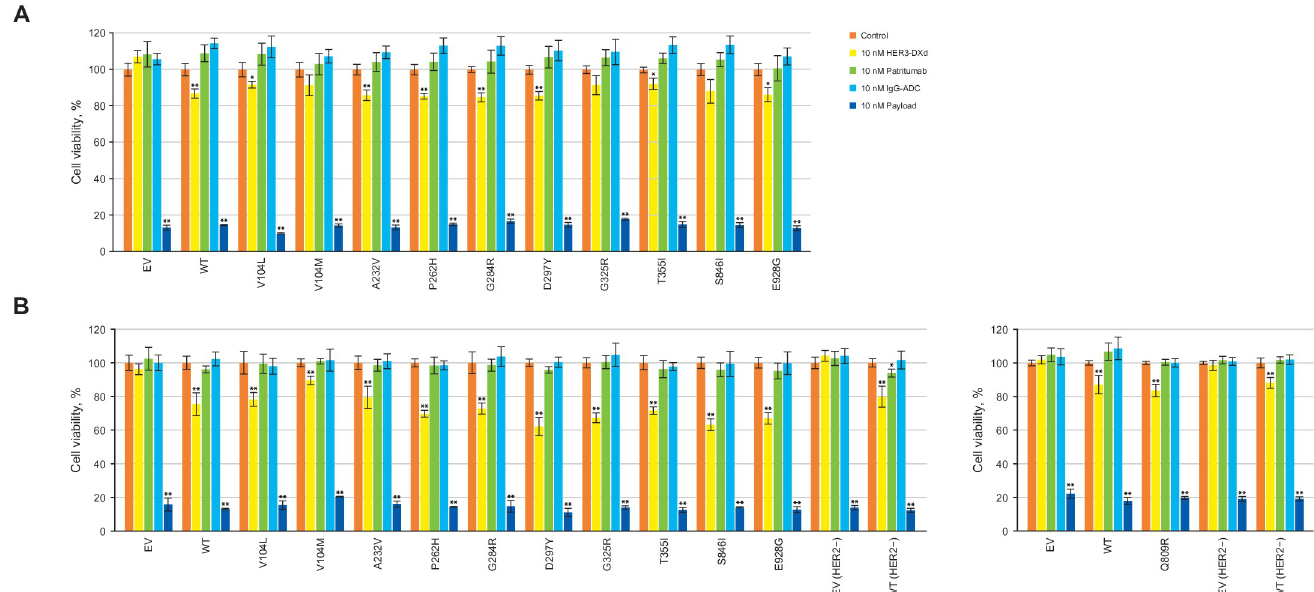
Fig 3. Cell-growth inhibition activity of HER3-DXd, patritumab, and payload against MDA-MB-231 cells transduced with HER3 WT , HER3 mutations, and HER3 EV in the absence (A) or presence (B) of HER2 overexpression. a Mean ± SD. � p < 0.01, �� p < 0.001. The effects of 10 nM of HER3-DXd, patritumab, or DXd payload on the growth of HER3 transfectants after 6 days of incubation were assessed and statistically compared with the control. Cell viability was calculated as the luminescence intensity of the test well divided by the mean luminescence intensity of untreated wells multiplied by 100. IgG-ADC is the negative control. Abbreviations: ADC = antibody drug conjugate, EV = empty vector, HER = human epidermal growth factor receptor, IgG = immunoglobulin G, SD = standard deviation, WT = wild type. a All data in part A are mean quadruplicates. In part B, all data are quintuplicates except for 10 nM payload, which is triplicate.